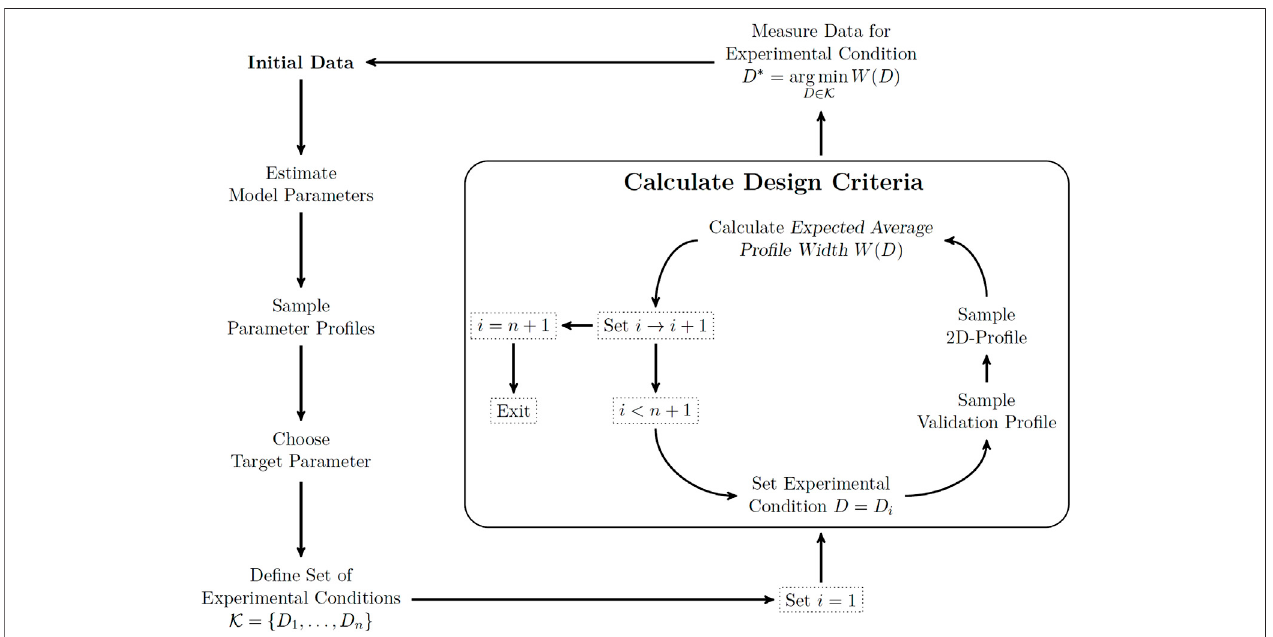
FIGURE 2 | Work fl ow for the sequential experimental design scheme. Starting from the current data set (top left), the target parameter is chosen and relevant experimental conditions are speci fi ed. Calculating the two-dimensional pro fi le likelihood and evaluating the expected average pro fi le width for each experimental condition(box)revealstheoptimalconditionforthenextmeasurement.Dottedrectanglesspecifythestateofthe forloop ,whiletextwithoutrectanglescorrespondtothe experimental design steps